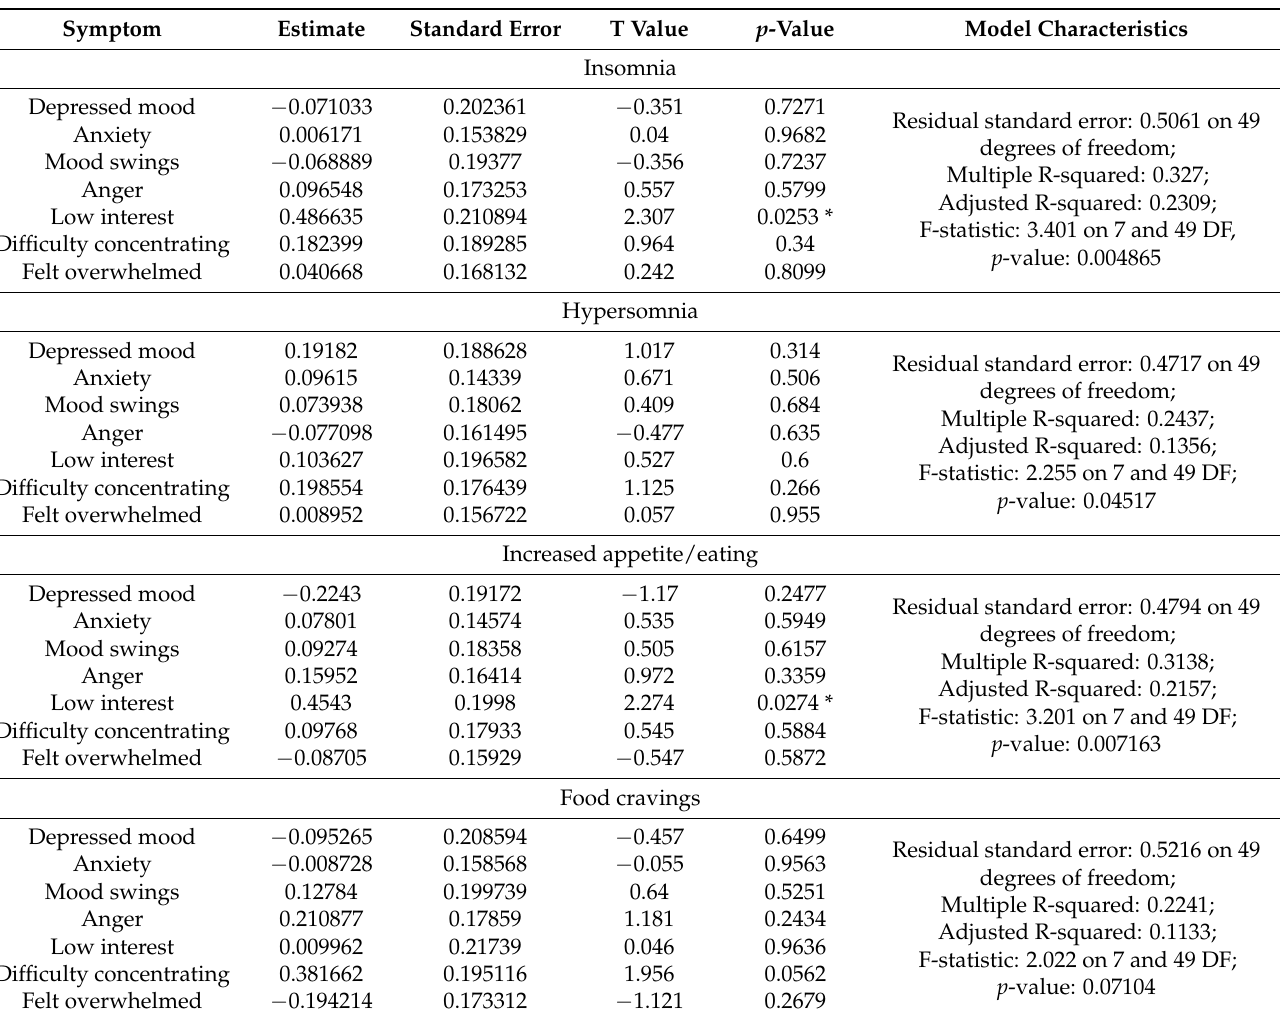
Table 2. Relationships between behavioral, affective and psychological premenstrual